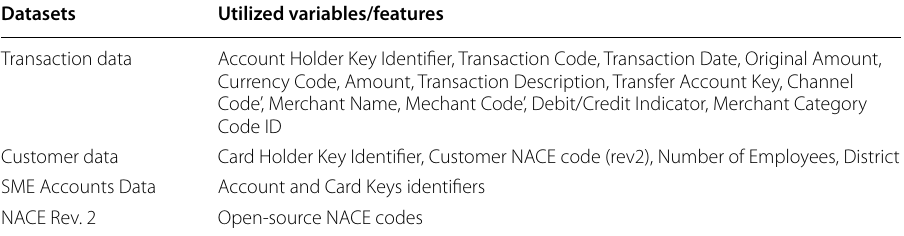
Table 1 Provided data sources by Bank of Cyprus Datasets Utilized variables/features